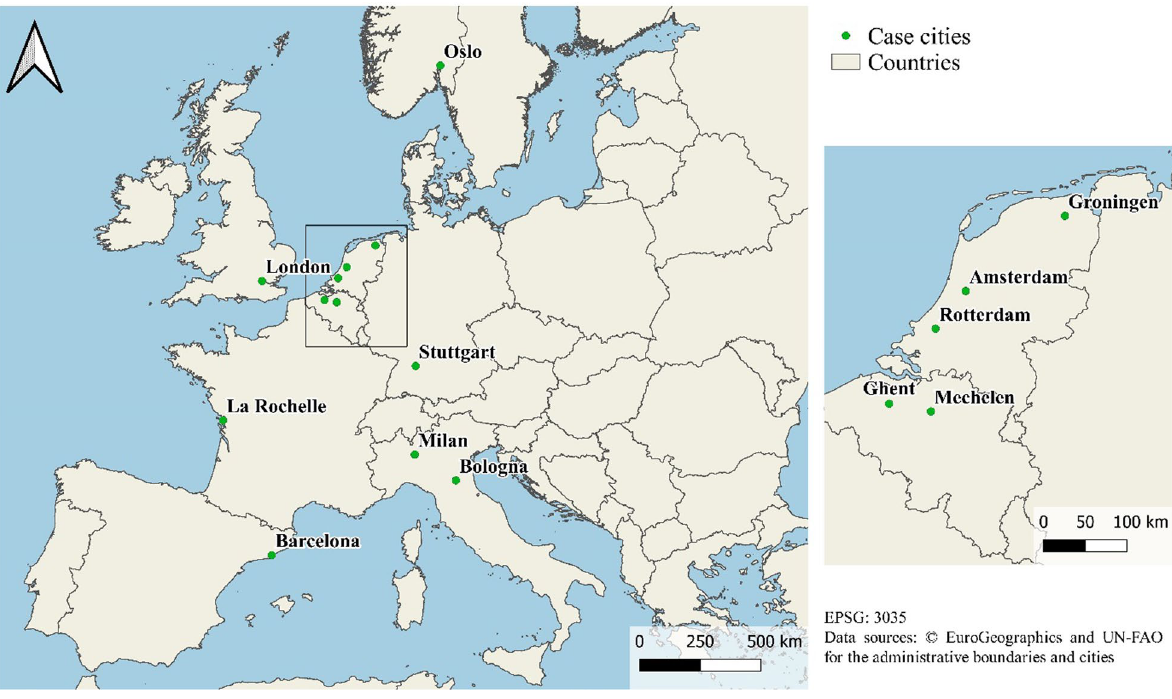
Fig. 1 Location of the twelve case study cities